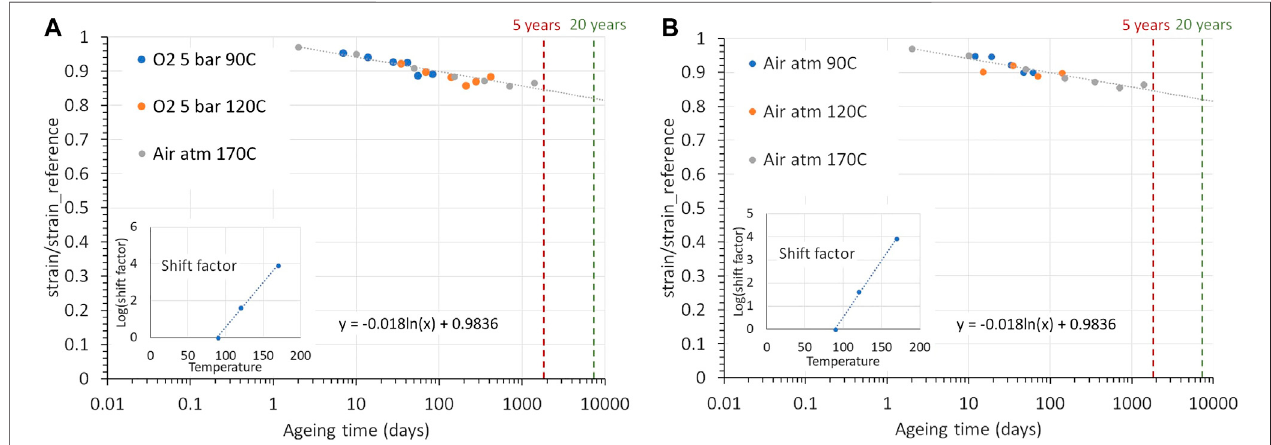
FIGURE14| Time-temperaturesuperpositionofstrainatUTSresultsofPSU (A) agedinoxygenand (B) inair.Theredandgreenlinesrepresentthetimeafter5and20